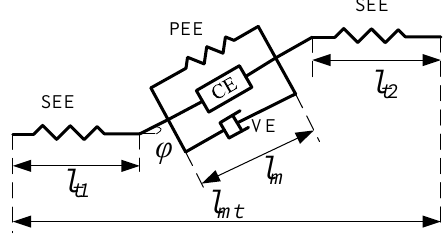
Figure 1. Hill muscle model.